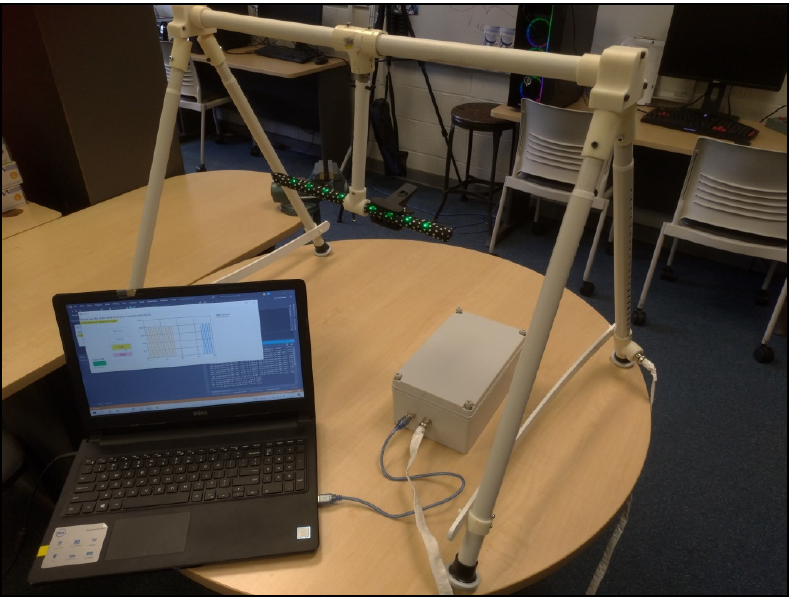
Figure 9. HUGS ‐ 2 connections: laptop/GUI, electronics box, bar toy, and frame. Figure 9. HUGS-2 connections: laptop/GUI, electronics box, bar toy, and frame.